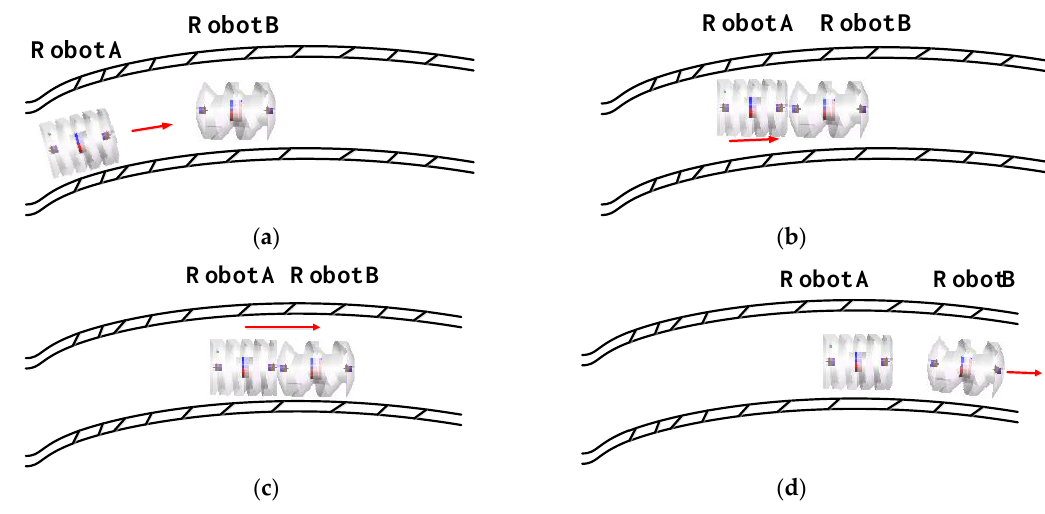
Figure 1. The concept of proposed multiple capsule robots in narrow body cavities: ( a ) the individual locomotion; ( b ) the docking procedure; ( c ) the cooperative locomotion; and ( d ) the release procedure.